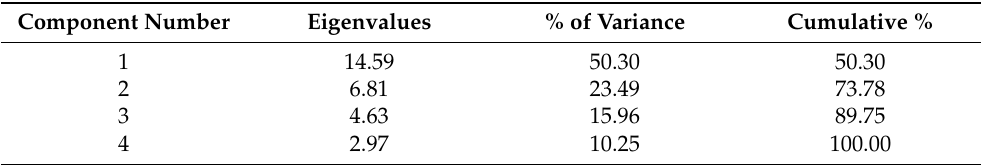
Table 2. Eigenvalue and accumulative contribution rate of tomato fruit quality and antioxidant capacity under different levels of water deficit.